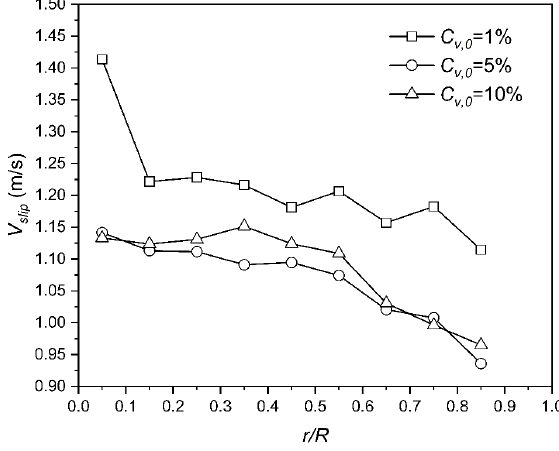
Figure 7. Effects of initial SVF on average slip velocity ( V mix ,0 = 4.0 m/s, d s = 15.0 mm).